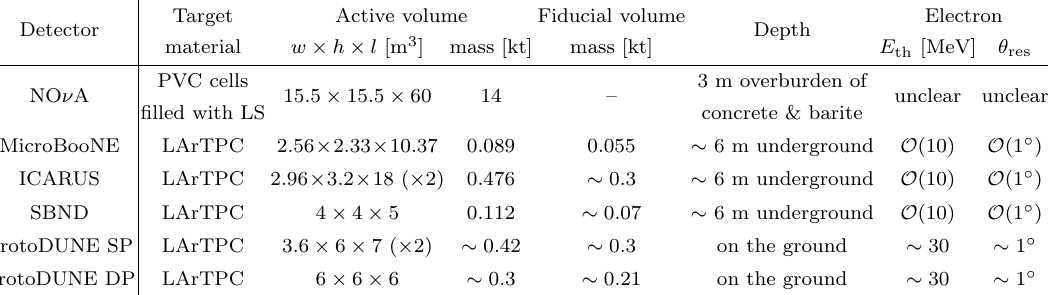
Table 1 . Summary of key characteristics of several surface detectors. See the text for the detailed explanation. The numbers with the \ (cid:24) " symbol are our estimations based on those of similar detectors due to the lack of o(cid:14)cial announcement. \ (cid:2) 2" in parentheses indicates that the relevant detector is composed of two consecutive equal-sized